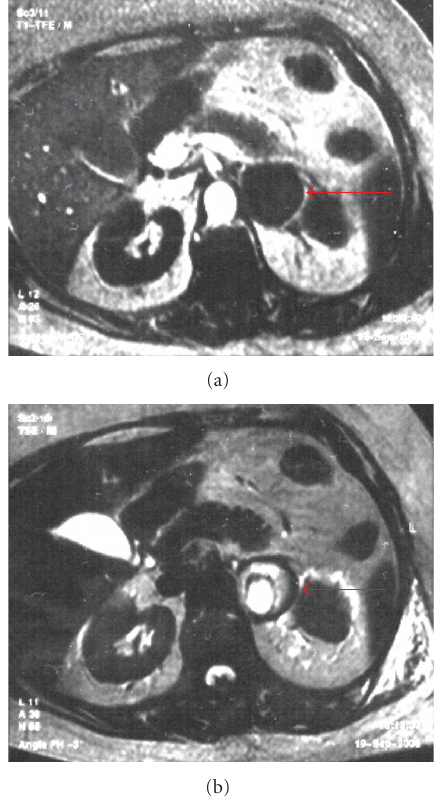
Figure 4: Abdominal MRI showing a large left suprarenal mass (red arrows). Right suprarenal is not seen in this view, but it was